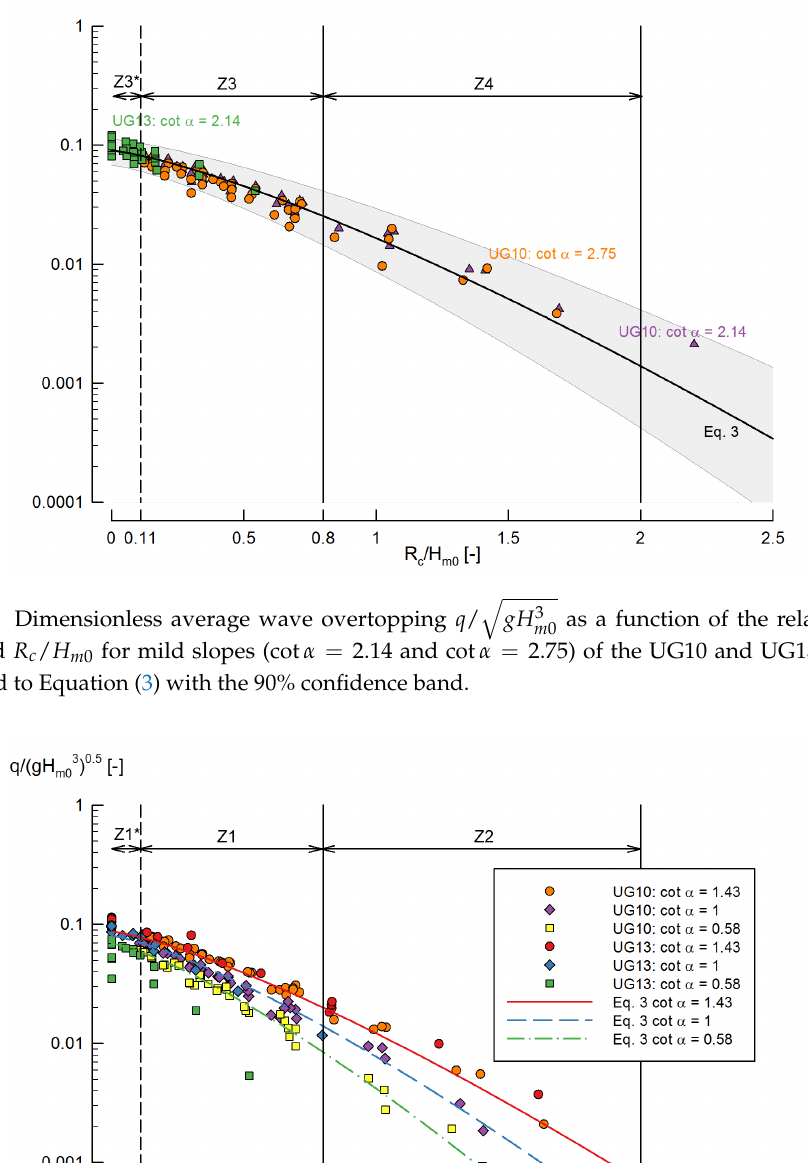
Figure 10. Dimensionless average wave overtopping q / freeboard R c / H m 0 for steep slopes (cot α = 1.43,1,0.58) of the UG10 and UG13 compared to Equation (3) with the 90% confidence